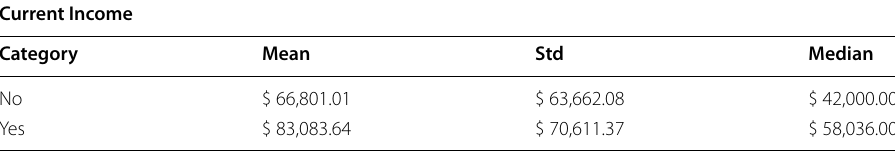
Table 5 First Income and Current Income median, mean, and standard deviation statistics by Graduate Degree